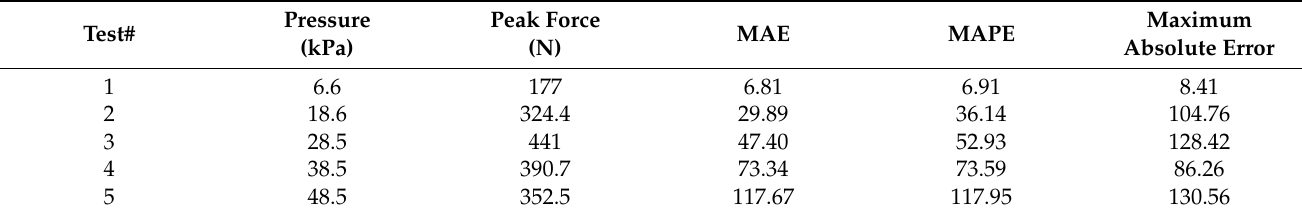
Table 5. Summary of the test data of the CFP-beamed